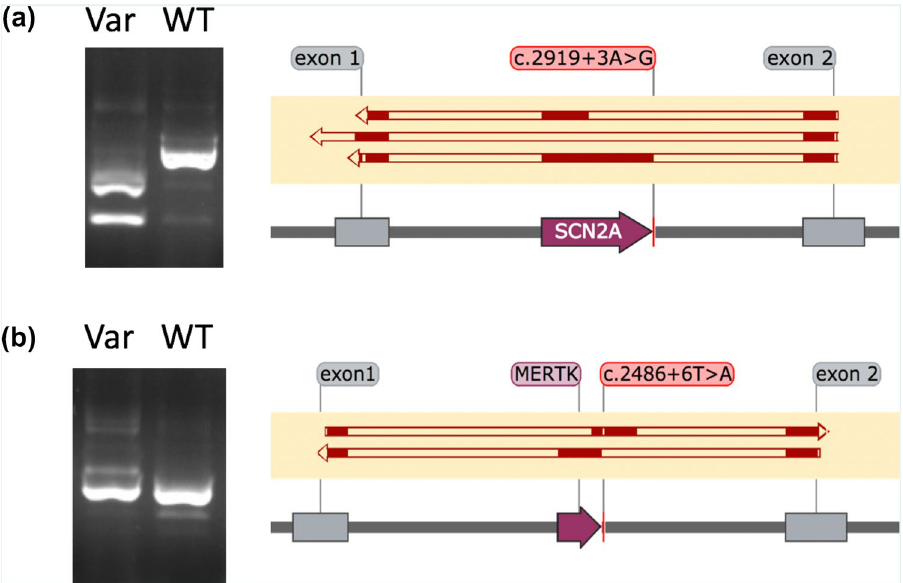
Figure 1. Results from in vitro minigene assays demonstrating multiple consequences as a result of variants proximal to the canonical splice site. Left, gel electrophoresis snapshots of cDNA products amplified from primers designed for control exons within the minigene ( exon 1 & exon 2 ). All prominent bands were cut out and Sanger sequenced. Right, solid red blocks illustrate alignment of sequenced cDNA transcripts to features within the minigene vector: control exons (grey boxes) and inserted exons (purple boxes); ( a ) SCN2A c.2919 + 3A>G, showing complete exon exclusion and exon truncation in minigene vectors containing the c.2919 + 3A>G variant (top two alignments) and normal splicing in minigene vectors containing the WT sequence (bottom alignment). The first resulted in a transcript with a truncated exon, NM_001040142.1:r.2563_2710del, and the second resulted in a complete exon skip, NM_001040142.1:r.2563_2919del. It is noteworthy that if these events were also observed in vivo then they may be considered differently using ACMG criteria; the exon truncation event resulted in a frameshift and introduction of a premature stop codon ( PVS1 ), whereas the complete exon skipping event resulted in the inframe removal of 119 amino acids from the transcript ( PM4 ); ( b ) MERTK c.2486 + 6T>A, showing a shifting of the exon included in the reading frame in minigene vectors containing the c.2486 + 6T>A variant (top alignment) and normal splicing in minigene vectors containing the WT sequence (bottom alignment). This novel variant is present in two individuals with severe rod-cone dystrophy, and resulted in the simultaneous usage of a cryptic exonic splice acceptor site and a cryptic intronic splice donor site creating a novel exon (chr2:112,779,939–112,780,082, GRCh37 ), and a premature stop codon in the penultimate exon, p.(Trp784Valfs*10). Original images for both SCN2A c.2919 + 3A>G and MERTK c.2486 + 6T>A are presented in Supplementary Figure